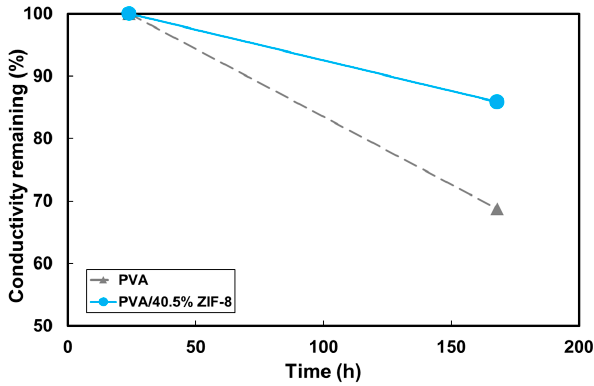
Figure 4. Alkaline stability presented in conductivity of PVA and PVA/40.5% ZIF-8 membranes as a function of time.